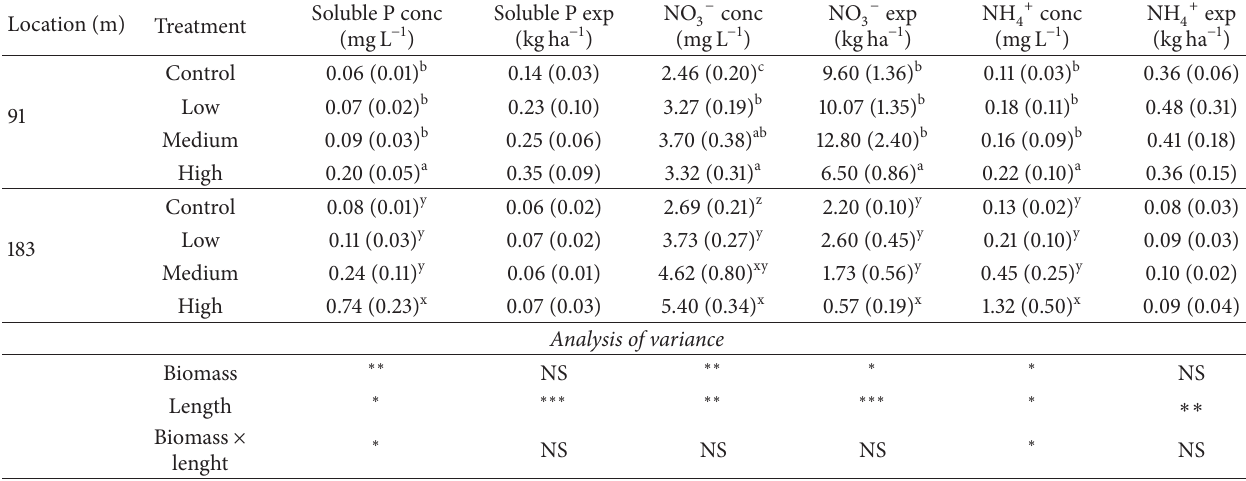
Table 3: Biomass residue and field length effects on soluble P, NO 3− -, and NH 4+ - in the 274 m long field. Shown are means (standard error), as well as analysis of variance results. 𝑛 = 3 .